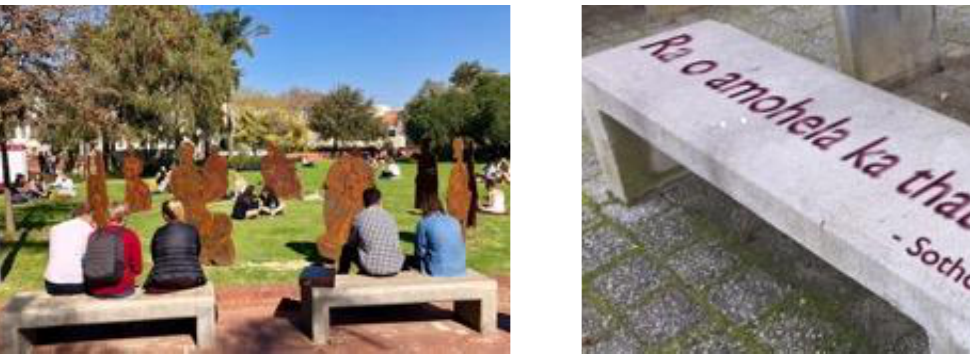
Figure 1 : Sculpture of eleven women in a circle Figure 2 : An example of a